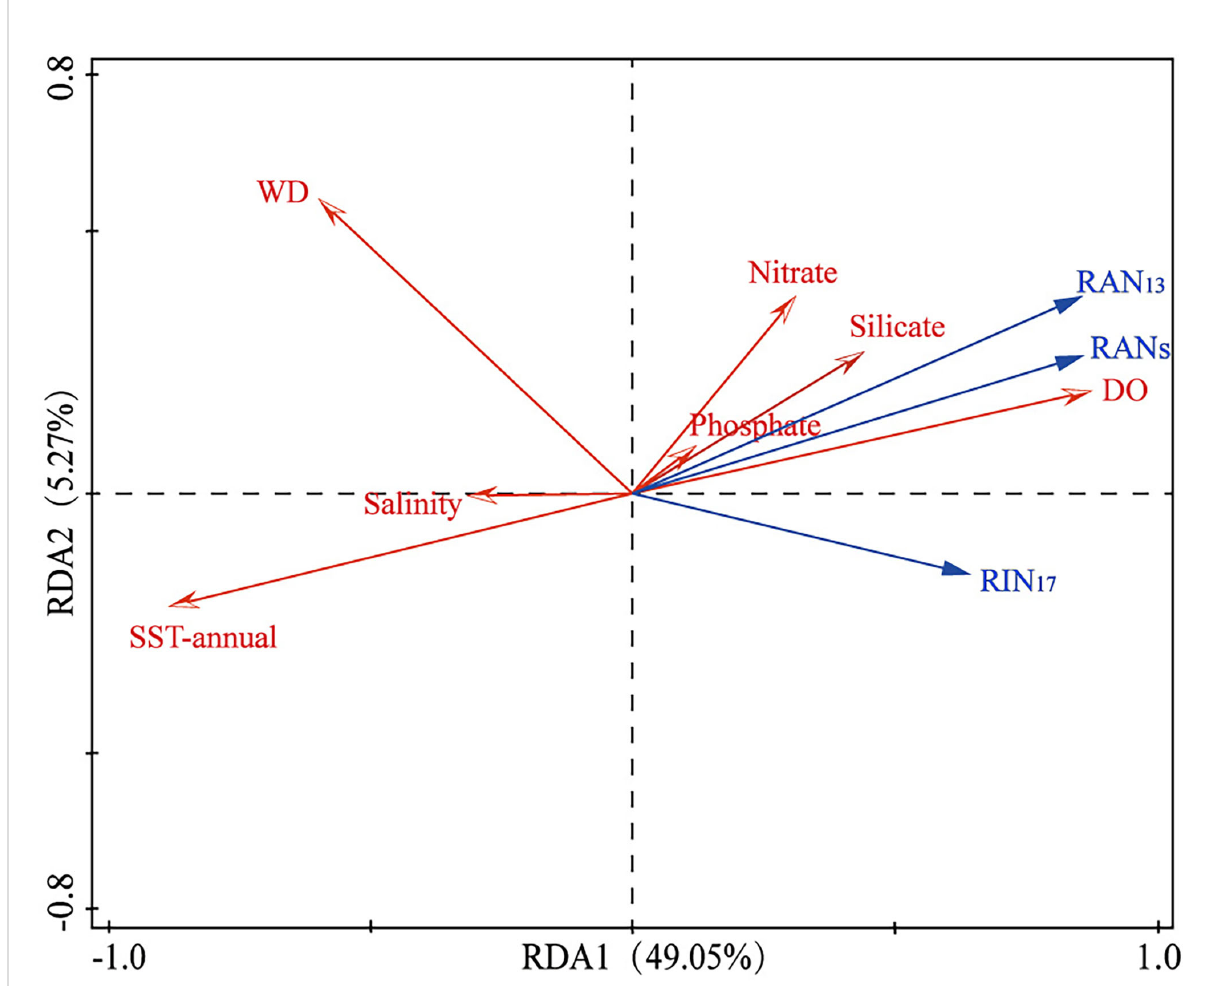
FIGURE 5 RDA biplot showing the relationship between environmental parameters and 3-OH-FA based proxies. The RDA1 explains 49.05% variation and RDA2 explains 5.27% variation (n = 77). WD, water depth; DO, dissolved oxygen